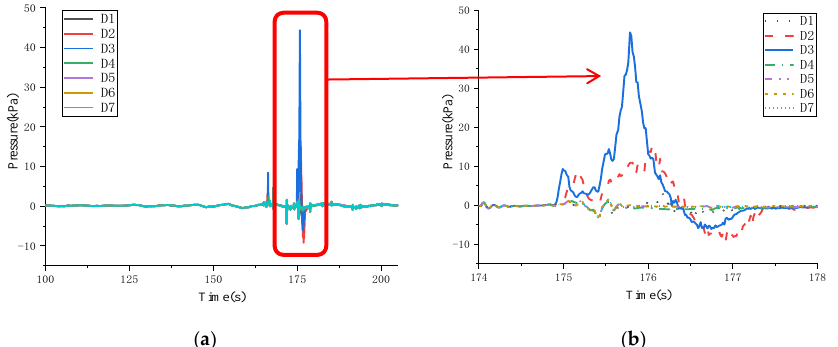
Figure 14. Pressure time series of D1 – D7 on wavefront surface of front column. ( a ) Global graphics. ( b ) Detail graphics.